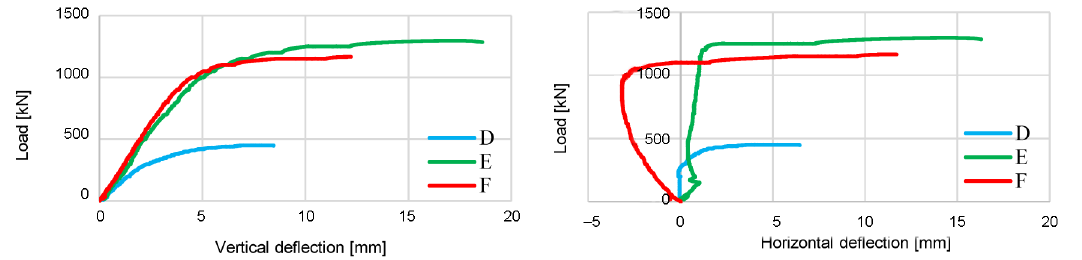
Fig. 7. Load-deflection curve in the vertical and horizontal direction for specimens D, E and